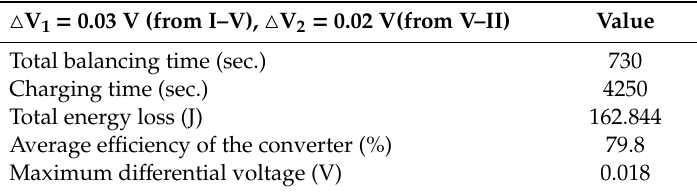
Table 5. Measurement of battery balancing process.